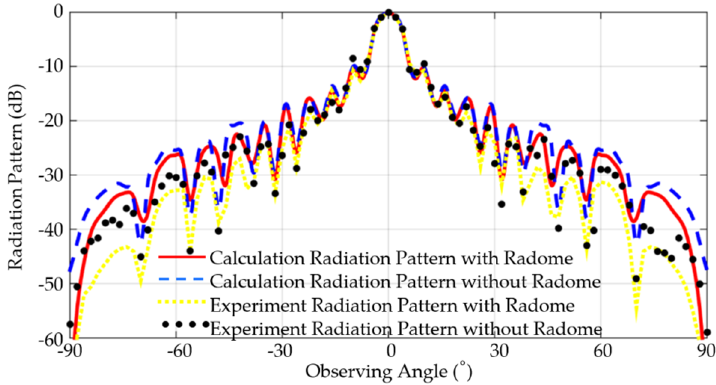
Figure 7. The 10 GHz calculation and experiment radiation patterns with and without the radome.